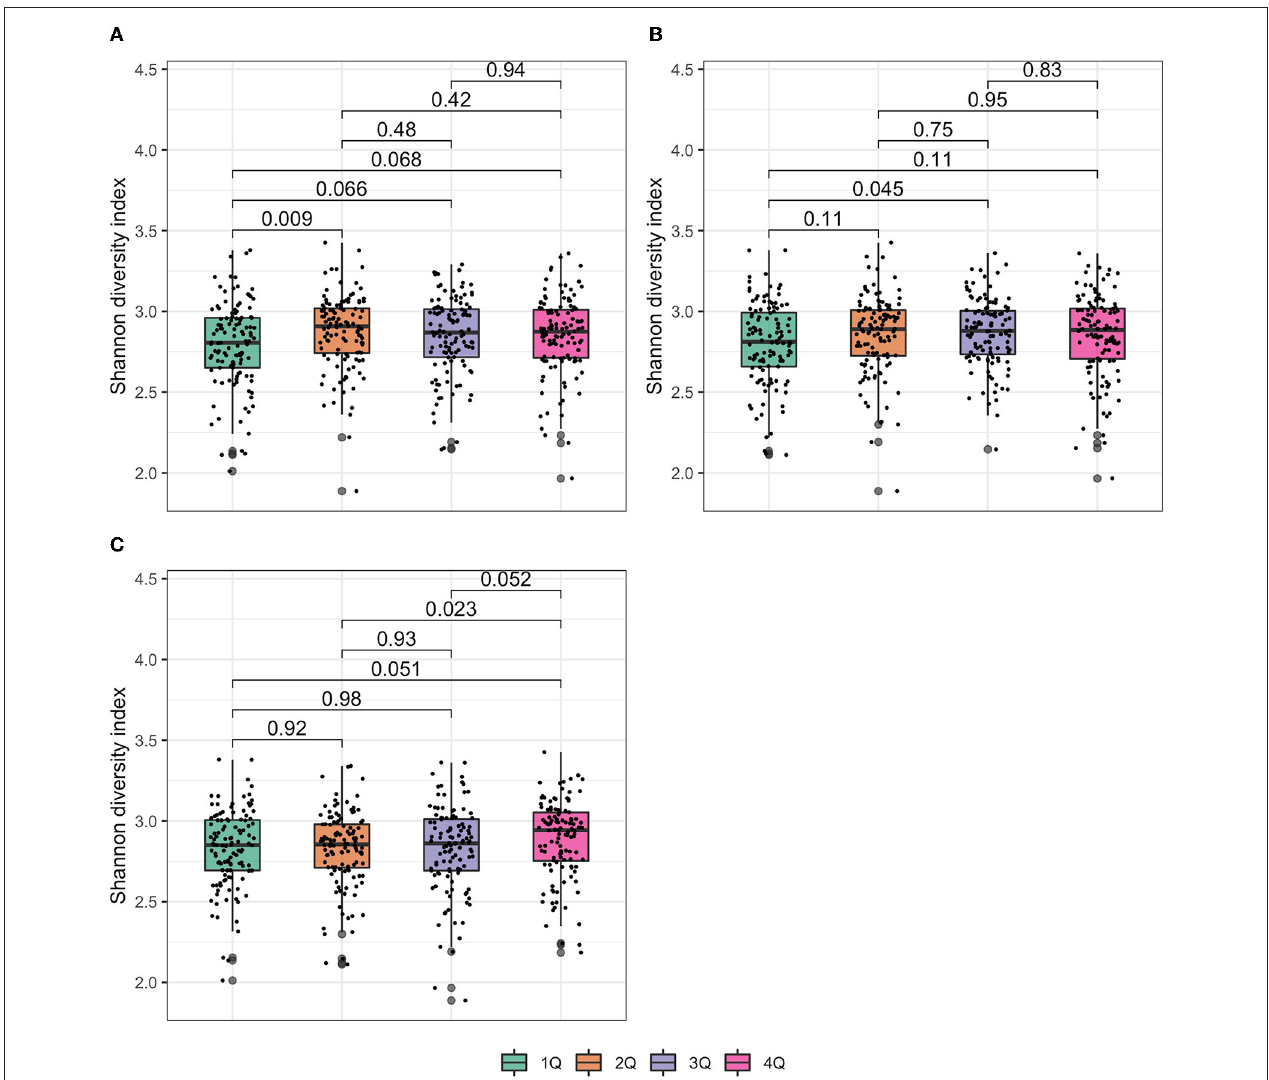
FIGURE 2 | Box plot of Shannon diversity index at the genus level. In the box plot, the lower and upper hinges correspond to the first and third quartiles (the 25th and 75th percentiles). The median is represented by a solid line within the box. The upper whisker extends from the hinge to the largest value (maxima) no further than 1.5 times interquartile range (IQR, distance between the first and third quartiles) from the hinge, the lower whisker extends from the hinge to the smallest value (minima) at most 1.5 times IQR of the hinge. Data beyond the end of the whiskers are called “outlying” points. N = 477 samples examined over study groups (denoted by different colors) and the data points are overlaid in each box. p values were given by Wilcoxon rank-sum test. (A) Methylparaben; (B) propylparaben; and (C)